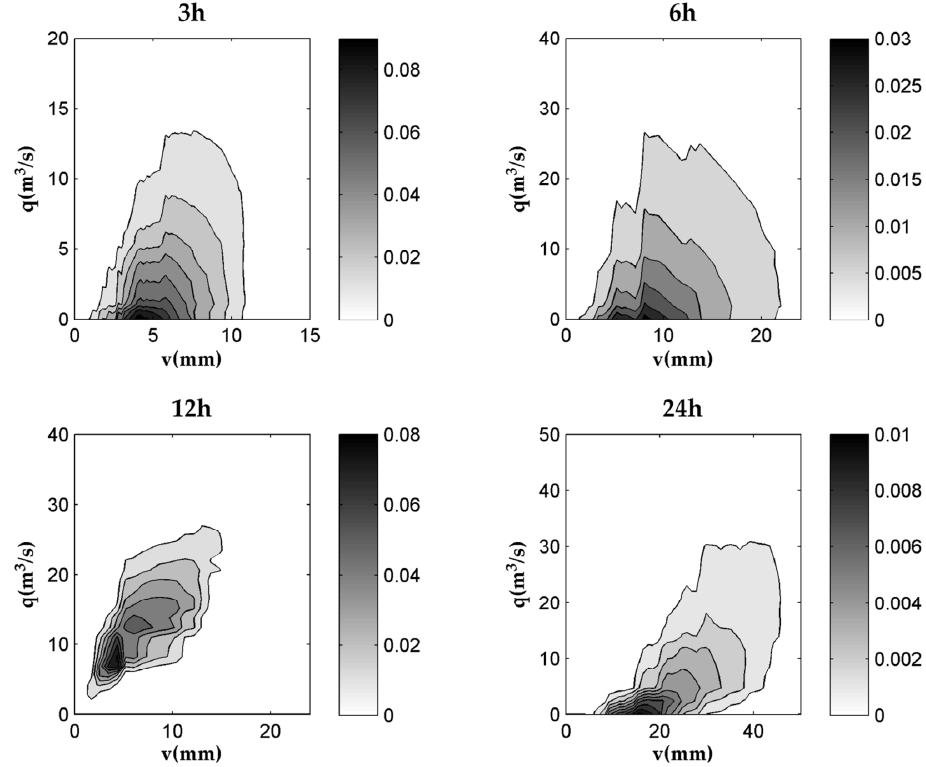
Fig. 3. Joint probabilities distributions for rainfall depth-cumulated rainfall (3, 6, 12, 24h), for soil AMCIII